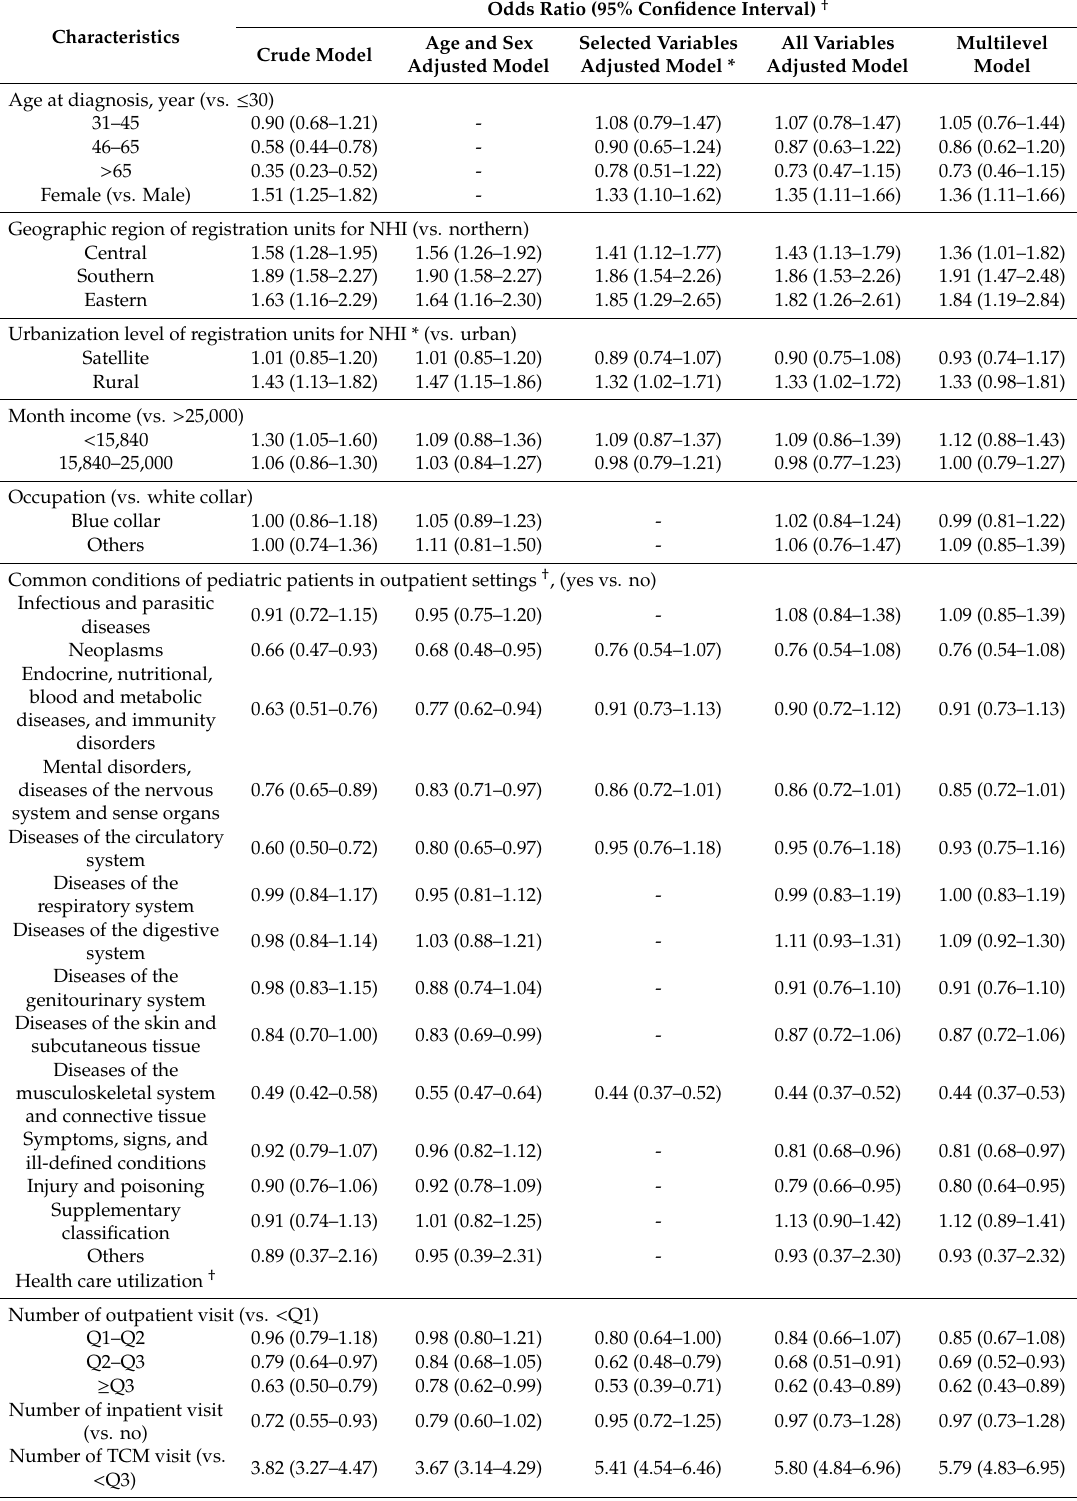
Table 3. Demographic characteristics, health care use, and medical conditions within a year before diagnosis were associated with using TCM as the preferred medical care in patients with carpal tunnel